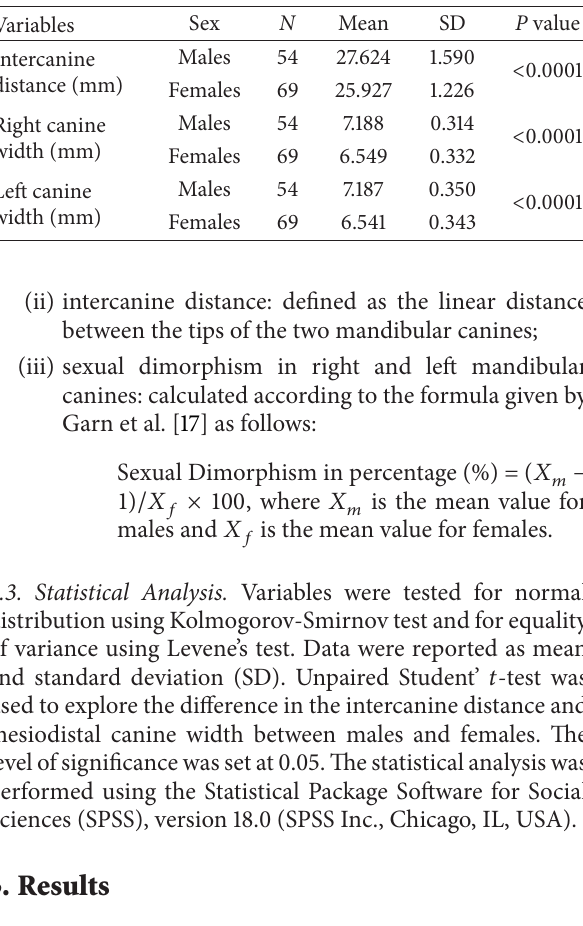
Table 1: Comparison of intercanine distance and canine width between males and